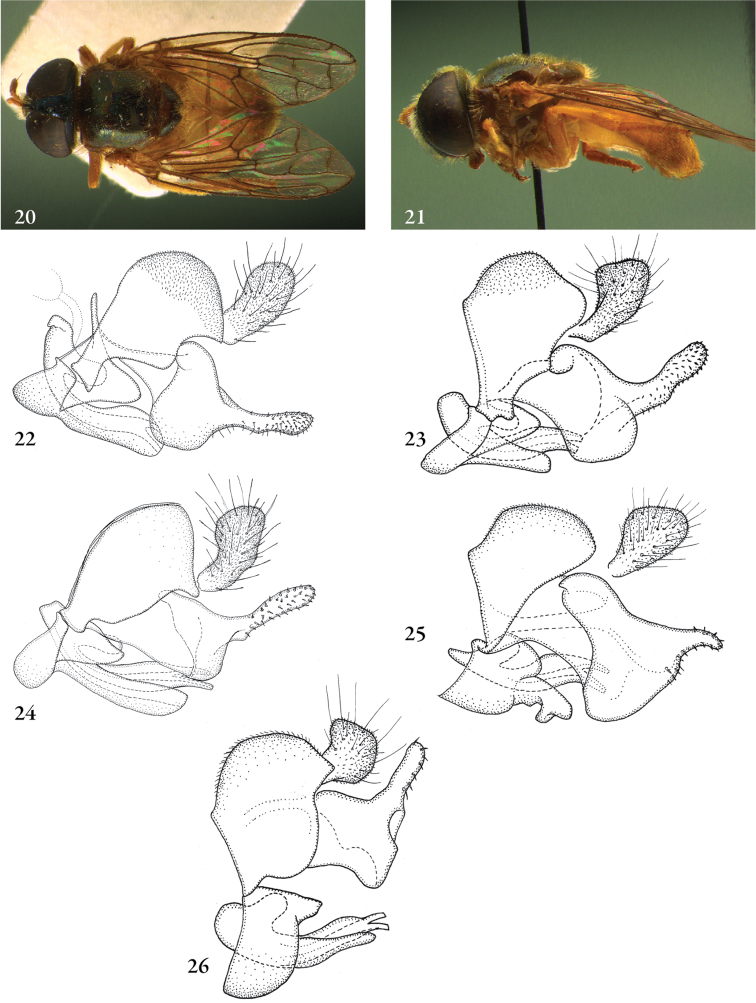
20–22
Archimicrodon (s.l.) fenestrellatus male (holotype): 20 habitus dorsal 21 habitus lateral 22 genitalia lateral 23–26
Archimicrodon (s.l.), male genitalia lateral: 23
Archimicrodon brevicornis (syntype) 24 Archimicrodon simplex (South Korea, coll. RMNH) 25
Archimicrodon venosus (holotype Microdon papuanus van Doesburg, jun. syn.) 26
Archimicrodon cf. fergusoni (Australia, coll. CSCA).